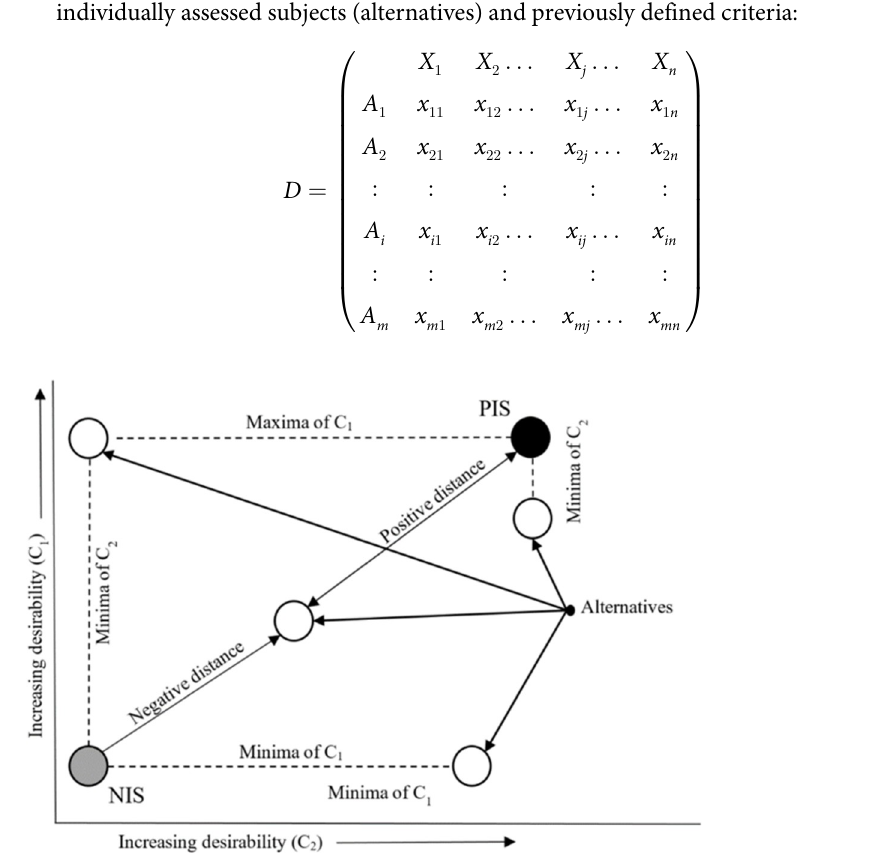
Fig 2. Graphical presentation of the TOPSIS